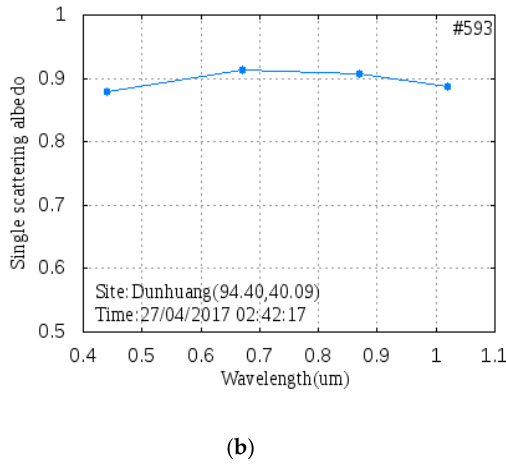
Figure 7. The aerosol properties retrieved at Dunhuang on 27 April 2017 including the ( a ) size distribution; and ( b ) single scattering albedo.